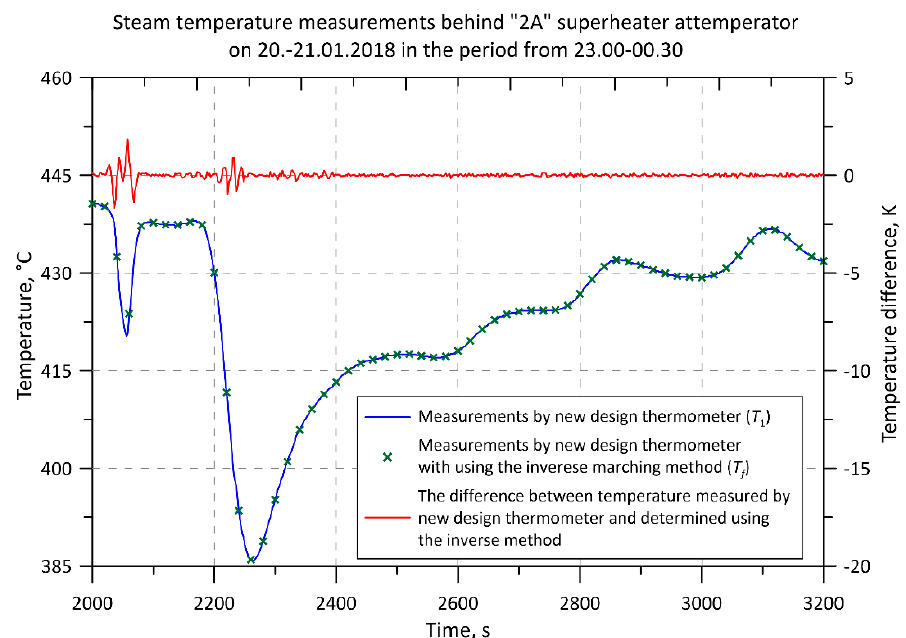
Figure 6. Comparison of superheated steam temperature downstream of the second superheater attemperator measured on side “A” in the K8 boiler by new design thermometers and determined using the inverse method (selected fragment).